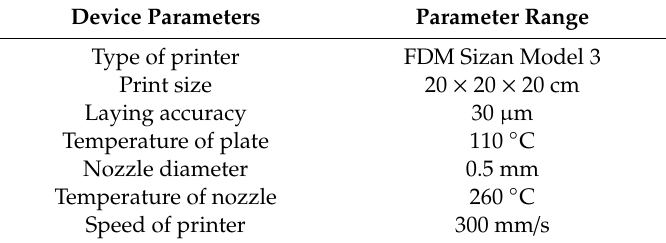
Table 3. Printer specifications.